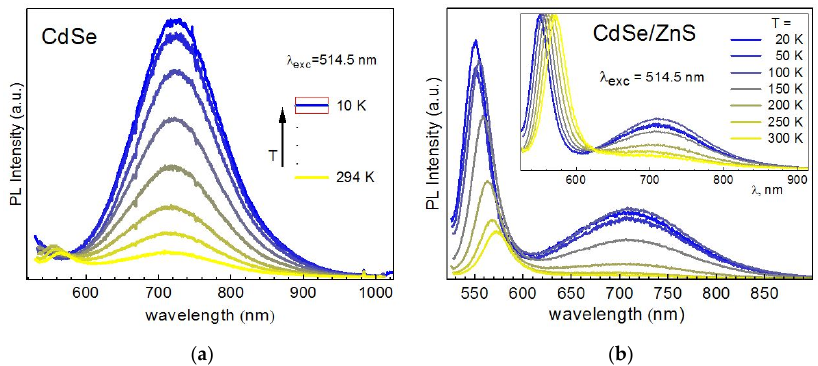
Figure 8. Temperature dependence of the PL spectra of CdSe ( a ) and CdSe/ZnS ( b ) NCs in gelatin matrix ( λ exc = 514.5 nm, 0.1 W/cm 2 ). Inset in ( b ) shows normalized curves.